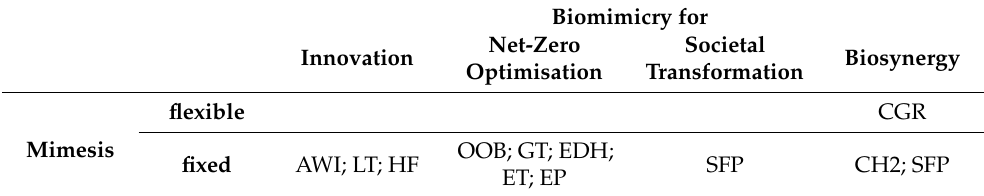
Table 6. Case studies from Section 3 classified according to the ‘Biomimicry for Sustainability’ framework. (Left: flexible or fixed mimesis; top: Biomimicry for innovation, net-zero optimization, societal transformation, or synergy). List of acronyms: EDH (Eastgate Development Harare), AWI (Arab World Institute), EP (Eden Project), CH2 (Council House 2), ET (Esplanade Theatre), OOB (One Ocean Building), GT (Gherkin Tower), SFP (Sahara Forest Project), HF (Homeostatic façade), and CGR (Cairo Gate Residence). (Adapted from